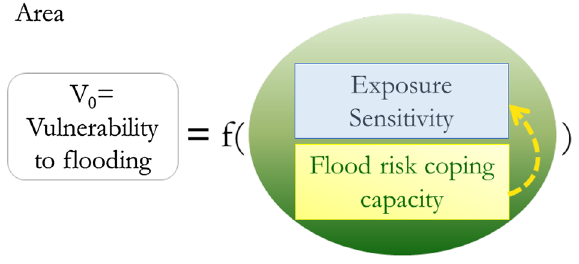
Fig. 1 Vulnerability to flooding — a conceptual framework. Source : Adapted from Guillier (2017)